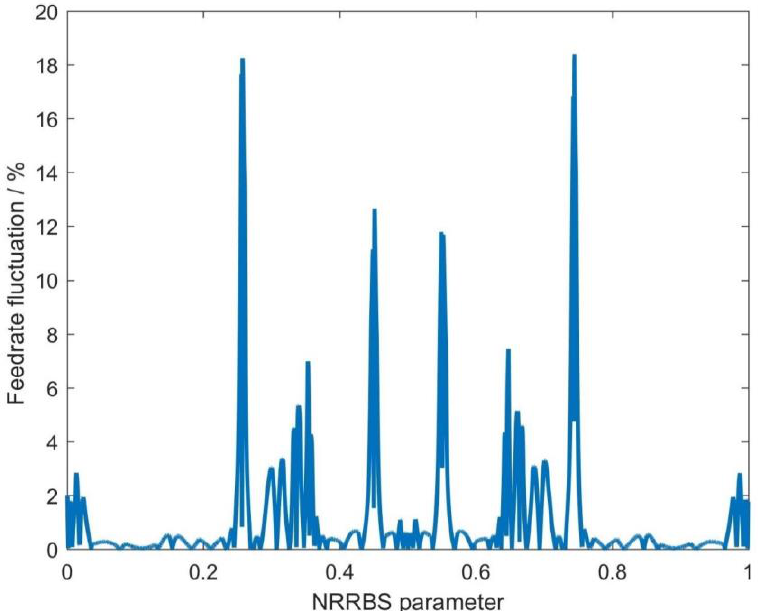
Figure 5. The feedrate fluctuation of the first-order adaptive feedrate method (FAM).